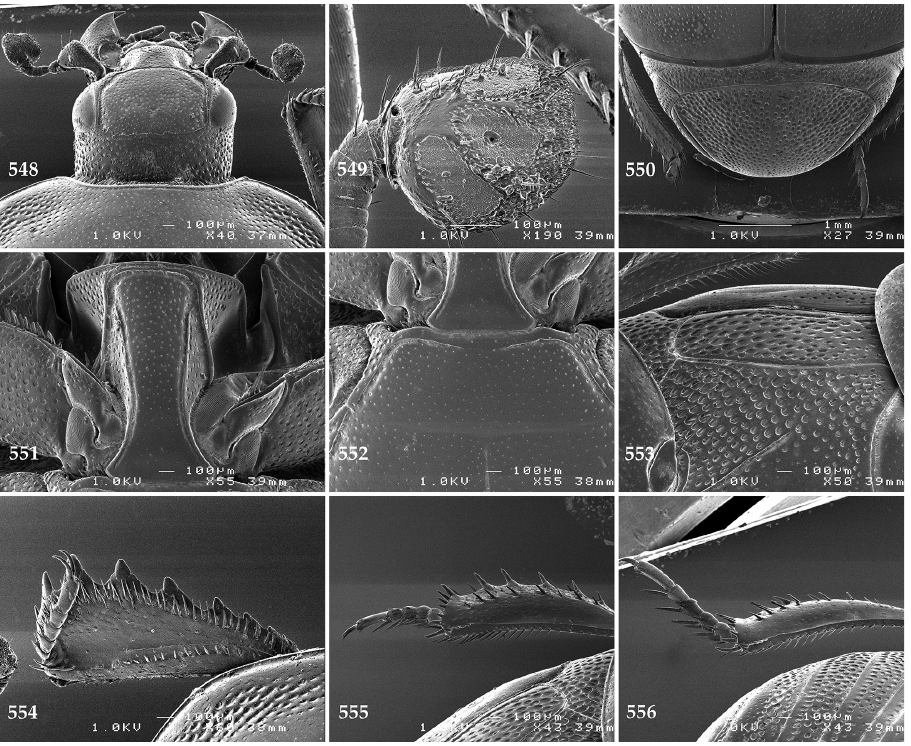
Figures 548–556. 548 Saprinus ( Saprinus ) splendens (Paykull, 1811) head, dorsal view 549 antennal club, ventral view 550 propygidium + pygidium 551 prosternum 552 mesoventrite 553 lateral disc of metaventrite + metepisternum 554 protibia, dorsal view 555 mesotibia, ventral view 556 metatibia, ventral